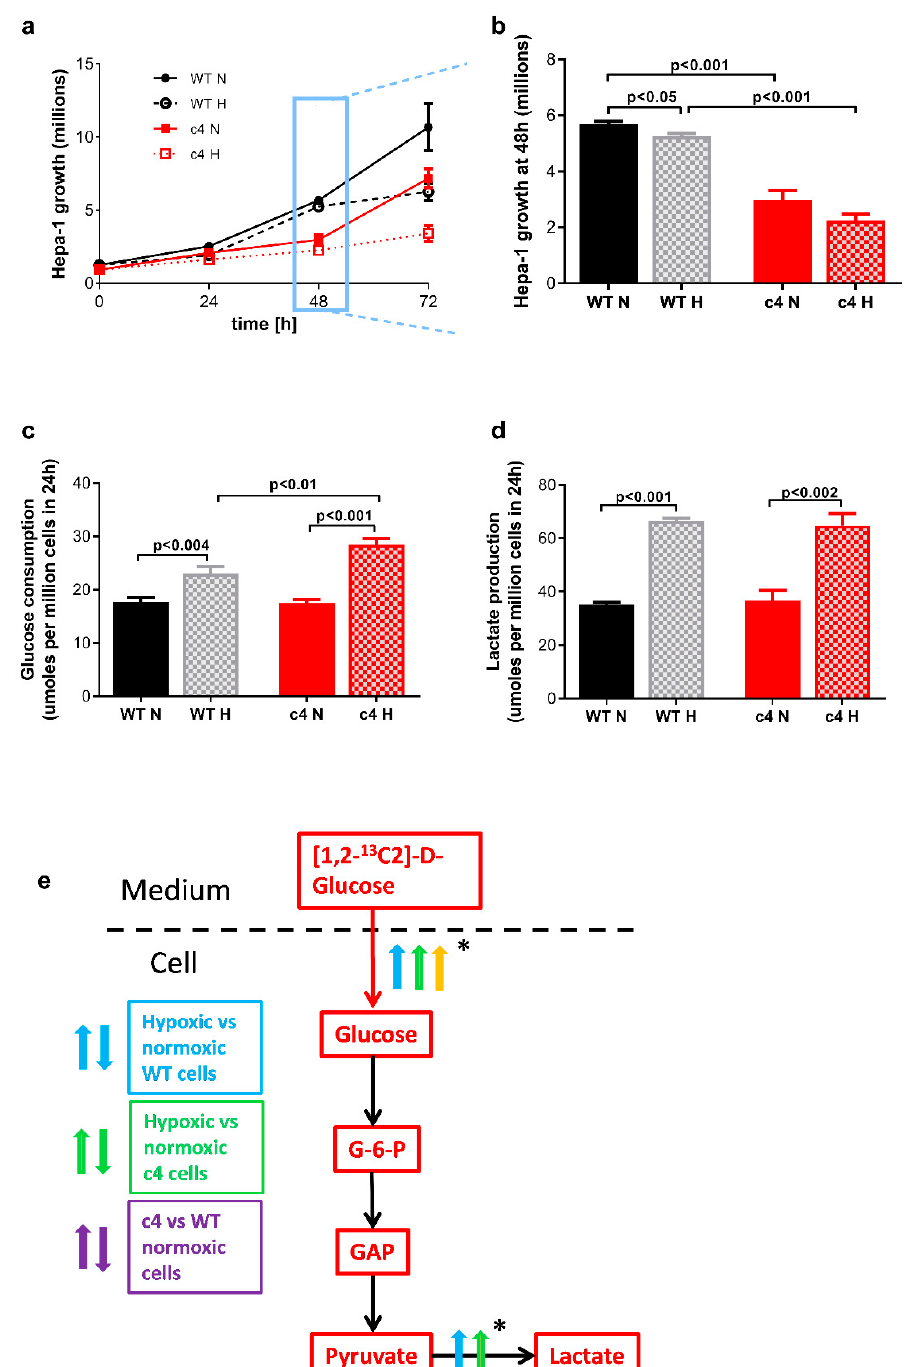
Figure 2. Cell growth, glucose consumption, and lactate output under normoxia and hypoxia in Hepa-1 WT and c4 cells. ( a ) Hepa-WT and Hepa-c4 growth profiles in normoxia and hypoxia ( n = 3). ( b ) Cell numbers at 48 h showed delayed growth in Hepa-c4 cells ( n = 3). ( c ) Glucose consumption at 48 h was elevated more by hypoxia in Hepa-c4 cells than in WT cells ( n = 7). ( d ) Lactate production at 48 h was equally elevated by hypoxia in Hepa-c4 cells and WT cells ( n = 5). ( e ) Diagram showing flux differences and changes between the two Hepa-1 cell types in normoxia and hypoxia. N, normoxia; H, hypoxia (1% O 2 ); arrows pointing upwards suggest significant increase for a given comparison. * Indicates differences in metabolic flux ( ↑ increased flux; ↓ decreased flux) due to HIF deficiency and hypoxia, which were inferred from concentration changes in the substances indicated. Panels ( a – d ) show data expressed as mean ± SEM; statistical significance assessed by unpaired two-tailed t